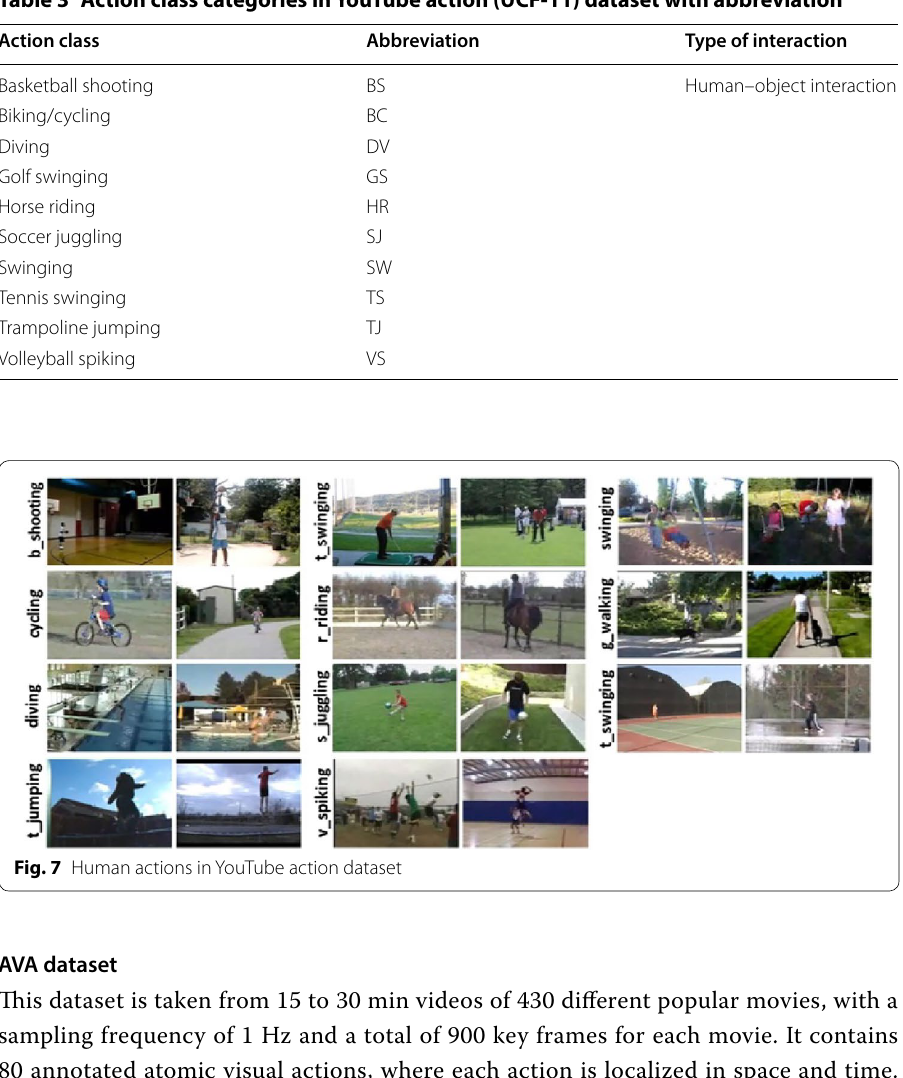
Table 3 Action class categories in YouTube action (UCF-11) dataset with abbreviation